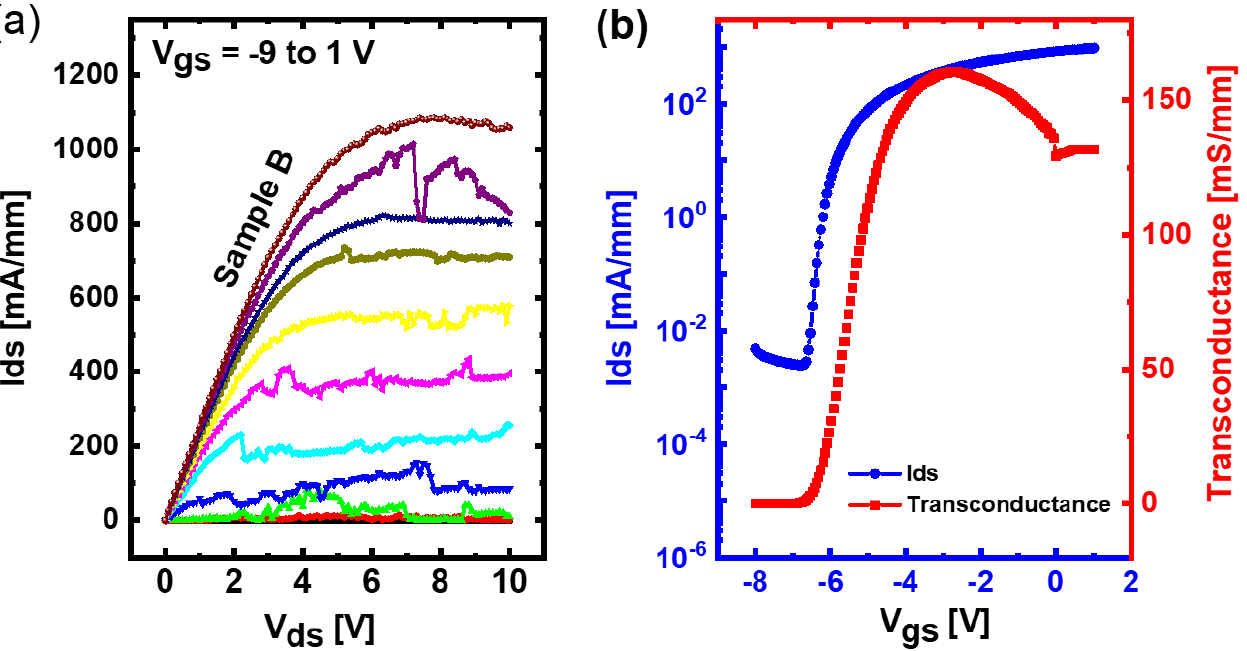
Figure 3. ( a ) Record I-V characteristics and ( b ) Consistent transconductance curves of a 10 µm gate length transistor for Sample B, the sample with the highest forward current performance.